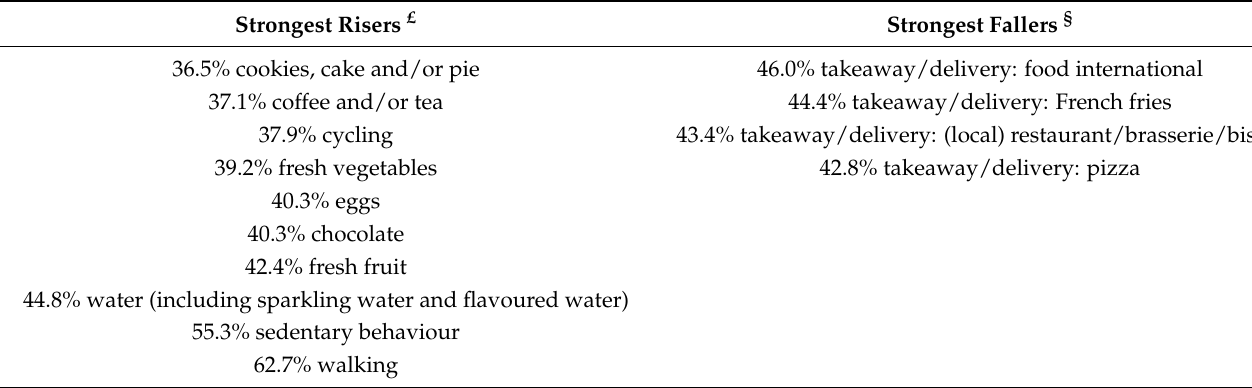
Table 4. Strongest risers and fallers in